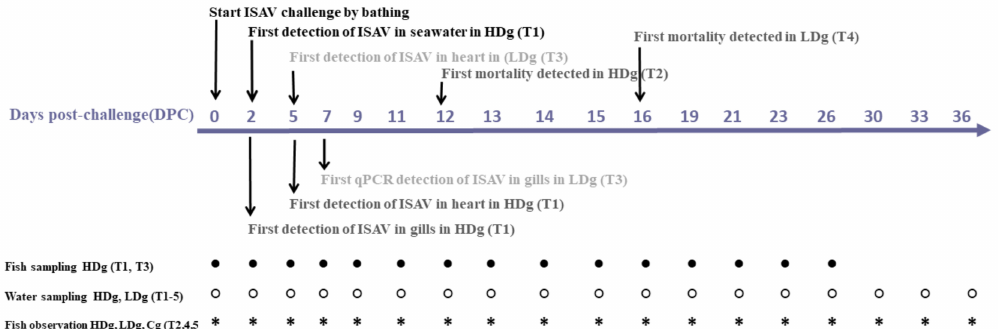
Figure 1. Schematic diagram of the experimental setup and summary of the results of infectious salmon anemia virus bath challenge trial with post-smolt Atlantic salmon. At day 0, fish in three different tanks were bath challenged with 2 × 10 4 TCID 50 /mL ISAV (high dose group; HDg), 2 × 10 2 TCID 50 /mL ISAV (low dose group; LDg), or virus-free L-15 cell culture medium (negative control; Cg). After 2 h bath challenge, fish from the three different challenge groups were distributed into five identical 500 L seawater tanks (T1–T5) as follows: high dose group (HDg) were transferred to sampling tank (T1) and observational tank (T2) respectively, low dose group (LDg) were transferred into sampling tank (T3) and observational tank (T4), while the negative control group (Cg) was transferred into tank (T5). At different days post challenge (DPC), seawater and fish samples were collected from the different